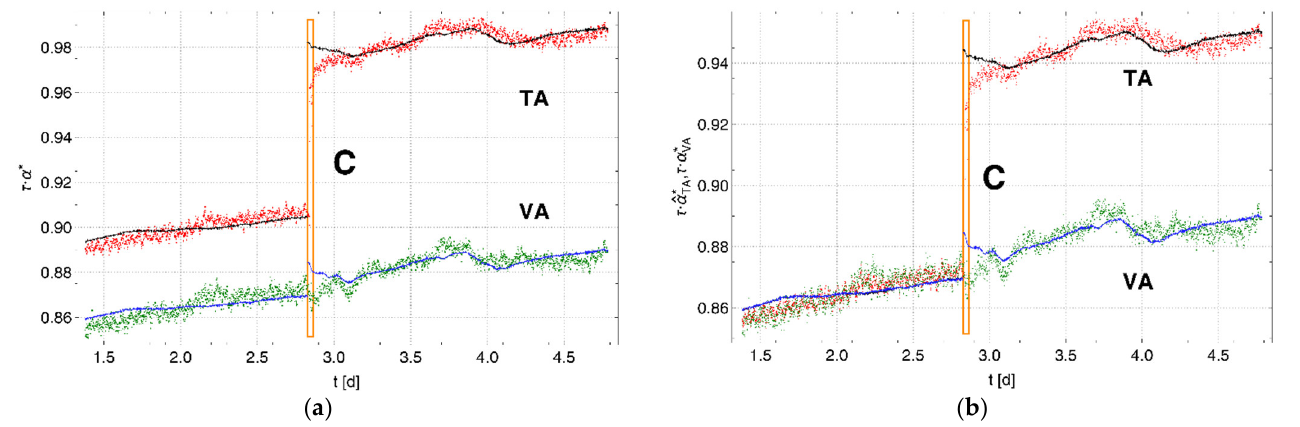
Figure 5. Pressure changes α ∗ (red) and α ∗ (green) multiplied by the time parameter τ of the Set 1 cell: ( a ) corrected for environmental influences and ( b ) adjusted to each other. The solid lines (TA: black, VA: blue) represent the respective calculated data. The data region within the orange box marked C represents the transition from Phase 1 to Phase 2, where the vapor-saturated air in the surroundings of the membrane tube in the test container was replaced by liquid water.